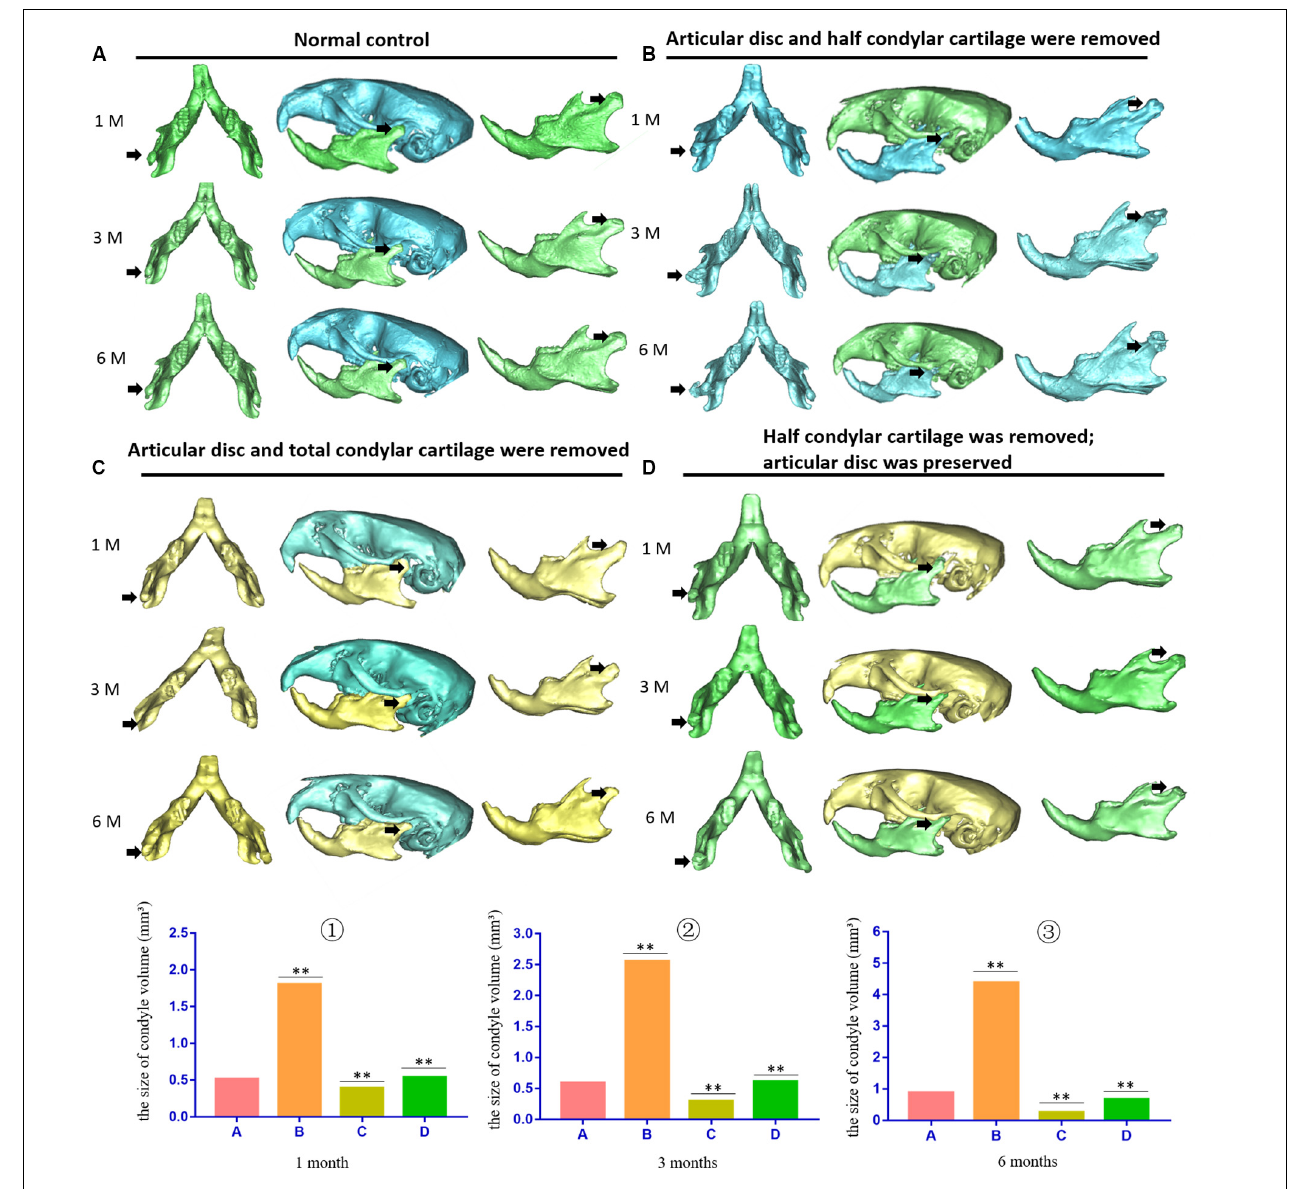
FIGURE 2 | 3D micro-CT of the skull and mandible of different animal models during the development of TMJ-THO. (A) Normal control TMJ of mice at the same time points after surgery. (B) TMJ structure of the first animal model (the articular disc and half condylar cartilage were removed) at different time points. Heterotopic ossification was obvious around the injured TMJ at different time points. In addition, the adhesion between the condyle and surrounding tissues also progressed over time. (C) TMJ structure of the second animal model (the articular disc and total condylar cartilage were removed) at different time points. There was no evident heterotopic ossification or adhesion around the TMJ. (D) TMJ structure of the third animal model (half of the condylar cartilage was removed, but the articular disc was preserved) at different time points. There was also no obvious heterotopic ossification or adhesion around the TMJ. The black arrow indicates the injured side of the TMJ. (cid:172) , (cid:173) , and (cid:174) showed that the volume of condyle in the first animal model was higher than that of normal condyle due to the formation of heterotopic ossification; however, the volume of condyle in the second or in the third animal model was lower than that of the first animal model at different time points. A,